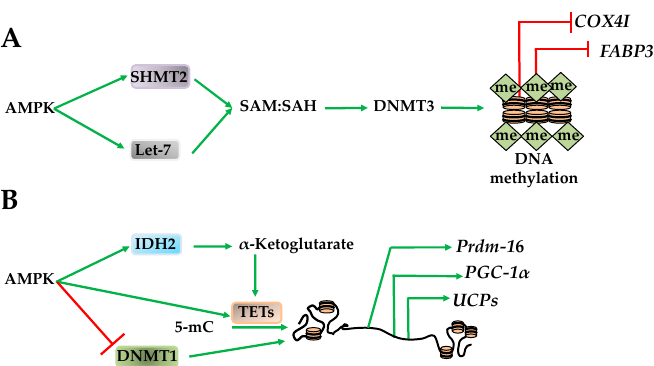
Figure 6. AMPK regulates DNA methylation. ( A ) AMPK activates serine hydroxymethyltransferase